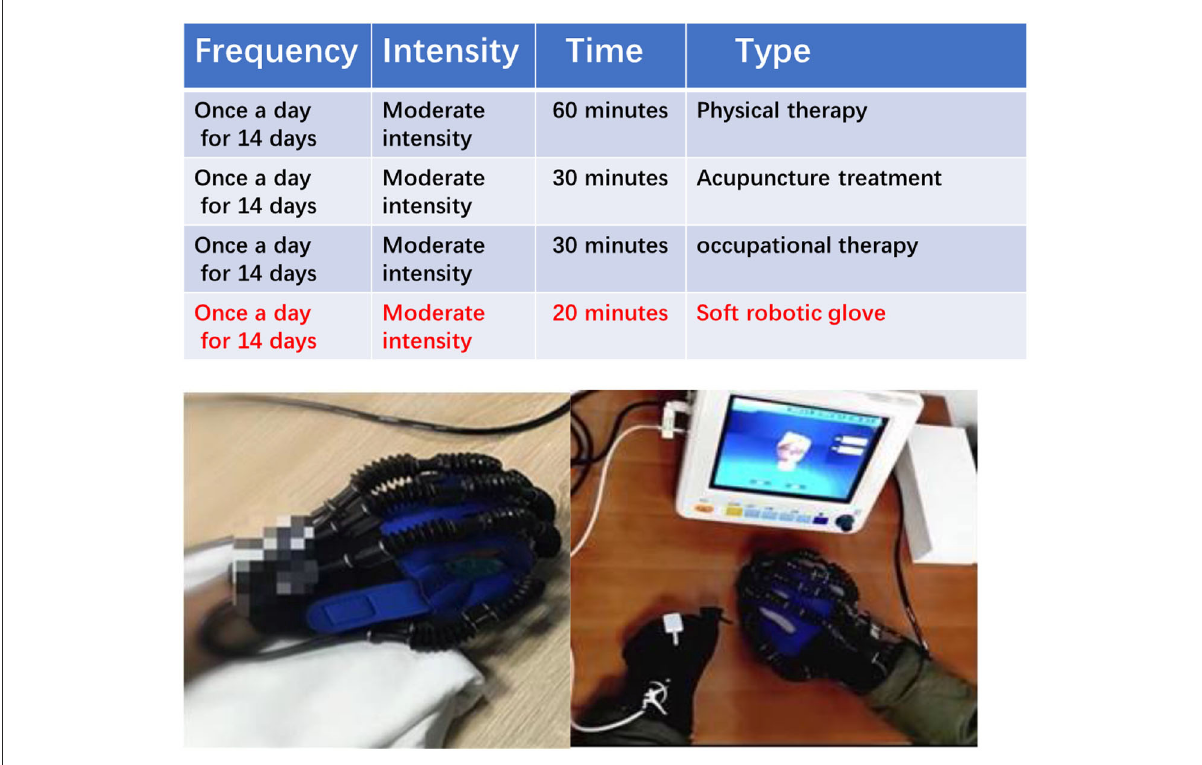
FIGURE3 A patient wearing soft robotic gloves for